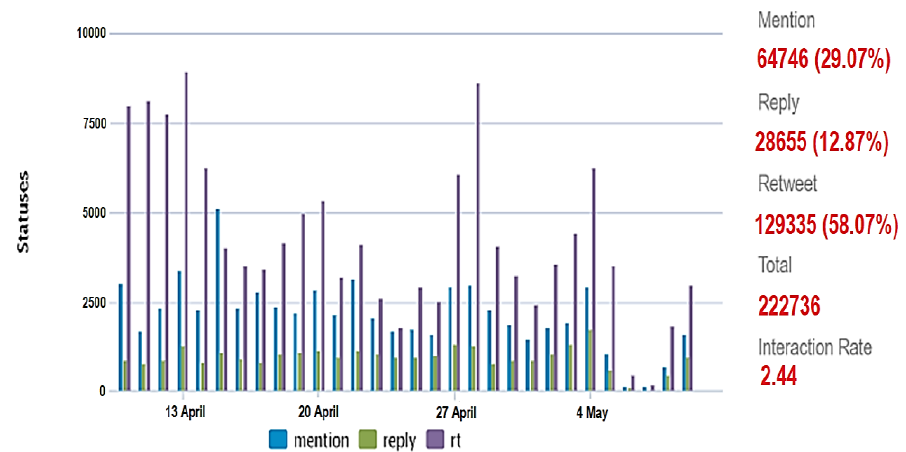
Figure 1. Dynamics of discussions on LSSR.